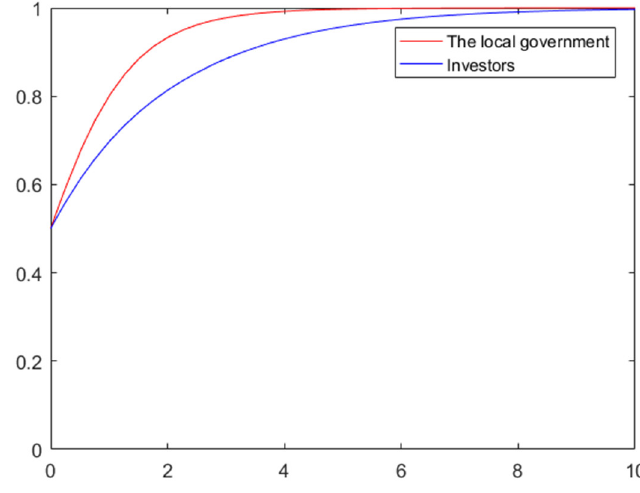
Figure 5. Simulation results in the bubble expansion stage .